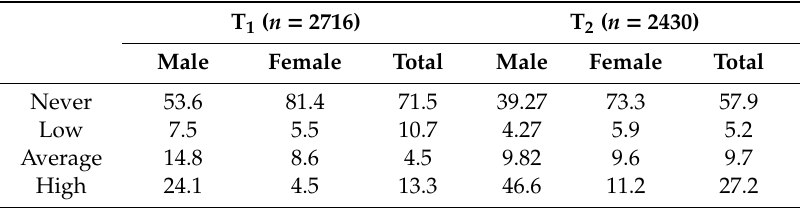
Table 1. Gambling frequencies by gender and totals for T 1 & T 2.